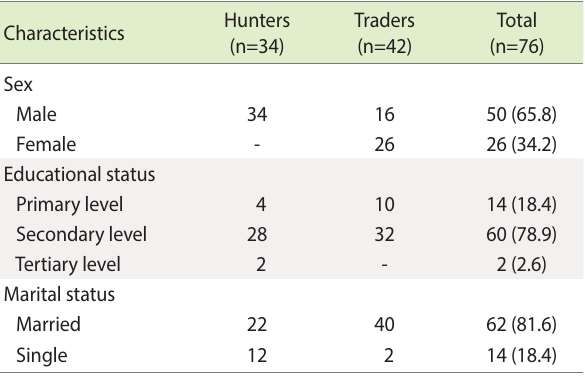
Table 1. Demographic characteristics of the subjects